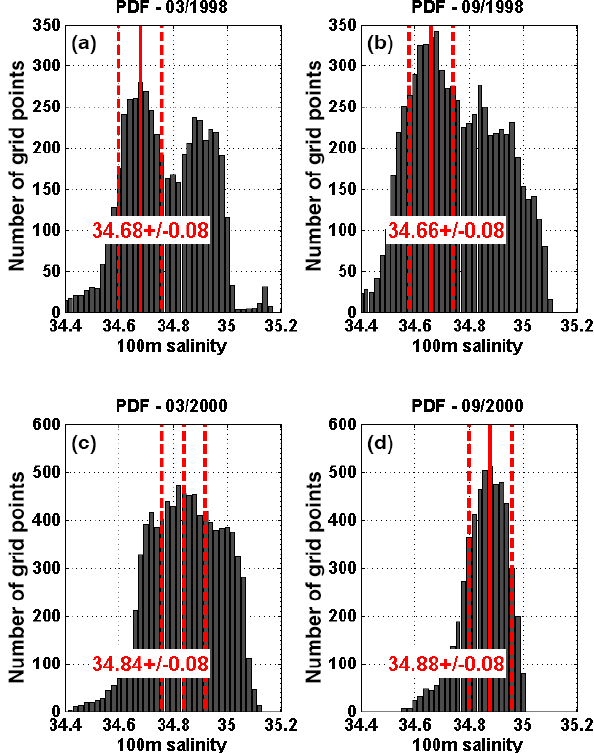
Figure 12. Probability density functions (PDFs) of the salinity fields (the period is indicated above each